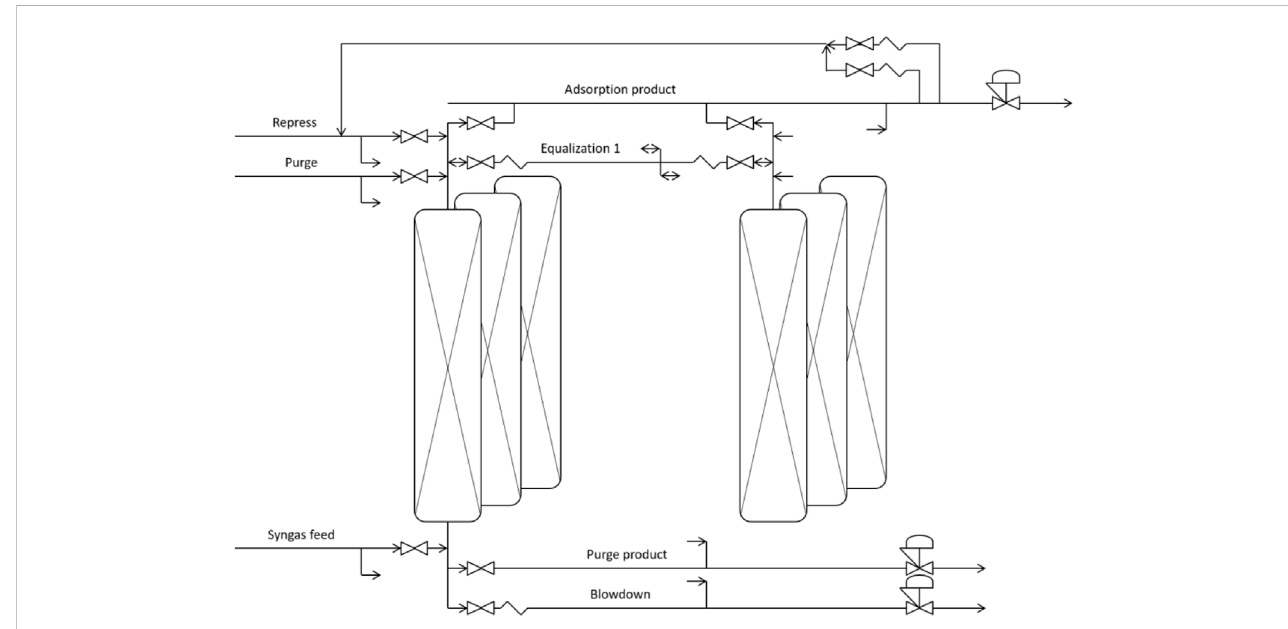
Schematic of 2 interconnect reactor columns, including the various feed and product streams. The connections shown for one reactor column are identical for all six columns in the multi-column